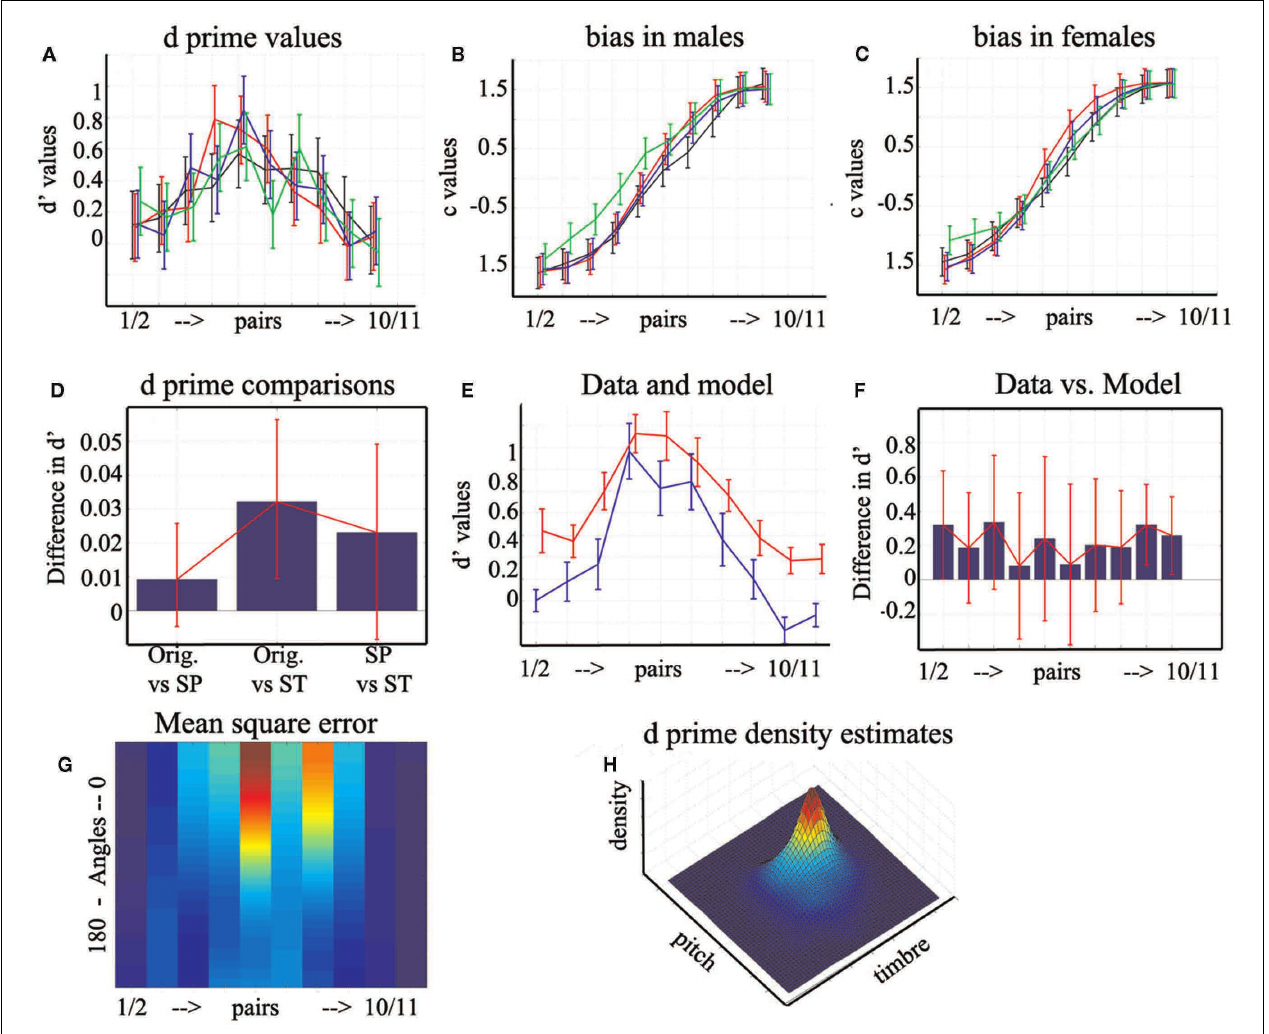
the bottom is the mean square error for each pair across all angles (G) from 0.21 in dark blue to 1.66 in red, along with the 3D representation of the joint kernel density estimates (H) . Note that because the axes are at 90˚ between pitch and timbre, the distribution is not spherical nor at the center of the space. Instead the distribution is elongated mainly in the timbre direction, i.e., high d (cid:2) values observed for ambiguous stimuli are biased toward using more timbre information.